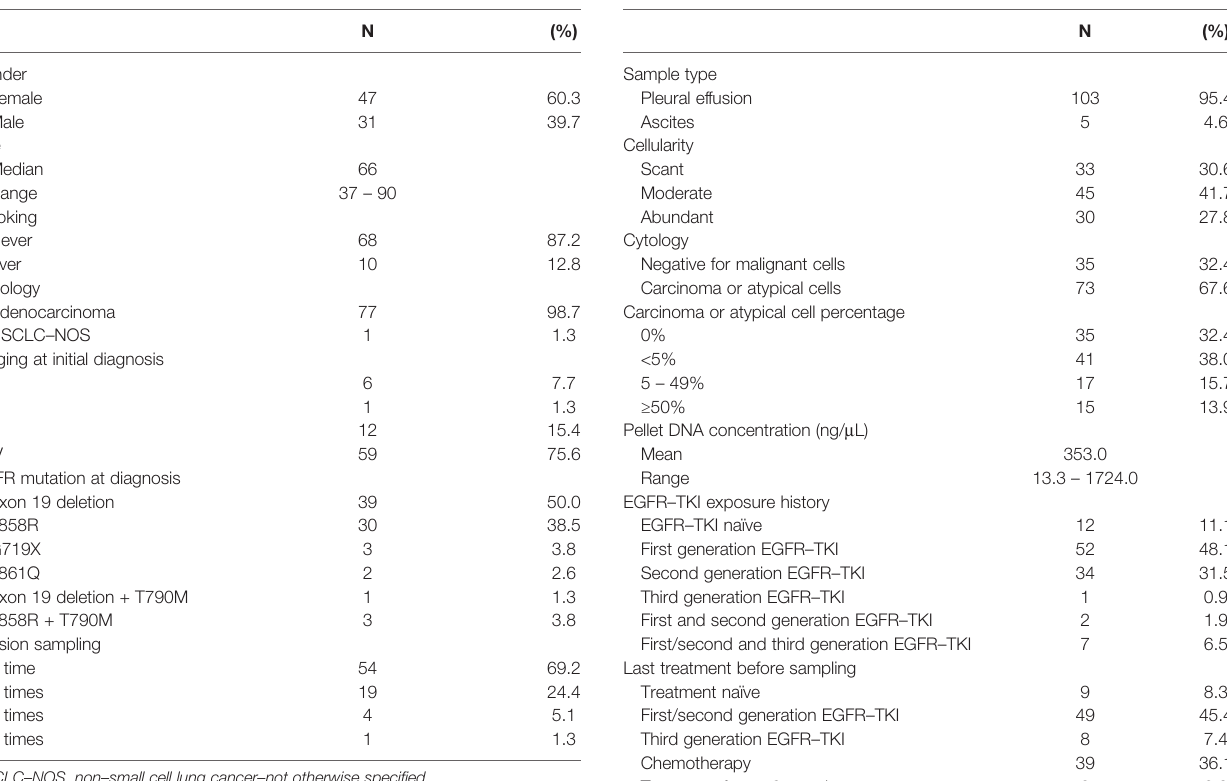
TABLE 1 | Patient characteristics (N = 78). TABLE 2 | Effusion characteristics (N =